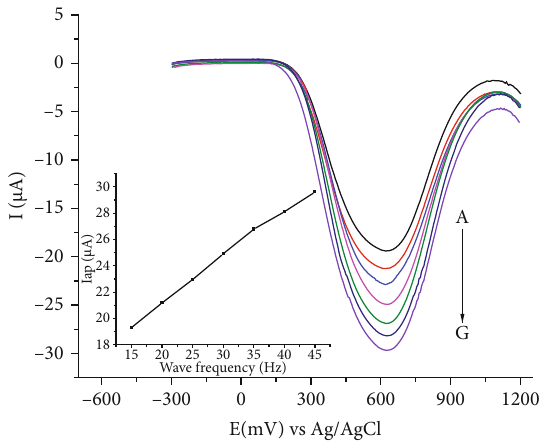
Figure 7: SWVs of AQMCPE in pH 4 PBS containing 2 mM AA at various frequencies (a – g: 15, 20, 25, 30, 35, 40, and 45 Hz, respectively). Inset: plot of anodic peak current vs. square wave